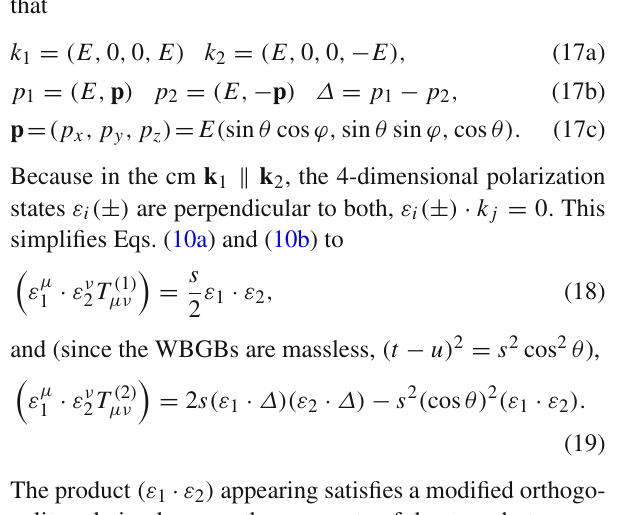
3 Matrix elements for γ γ to ωω and hh scattering at NLO The one-loop perturbative amplitudes for the production of γ γ from the EWSBS can be read off (by time reversal invari- ance) from those for γ γ → ωω scattering, computed in